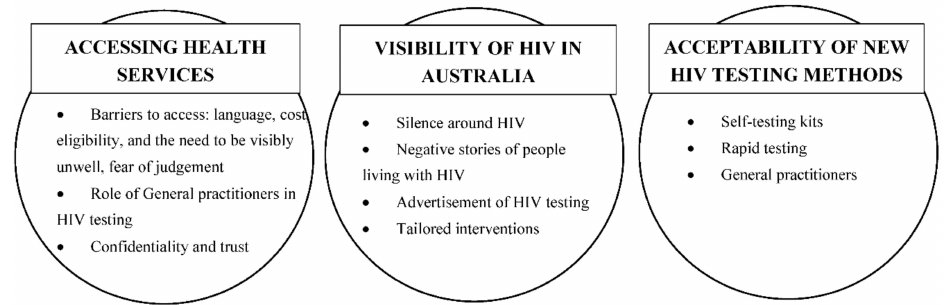
Figure 1. Core themes and